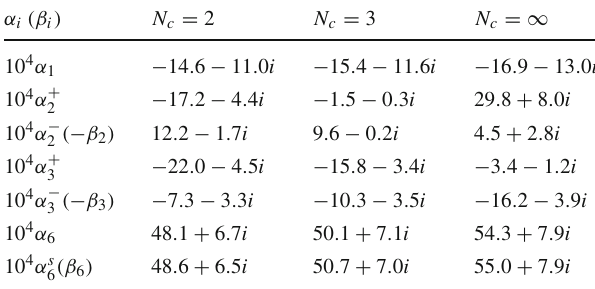
Table 1 The values of α i and β i with N c = 2 , 3, and ∞